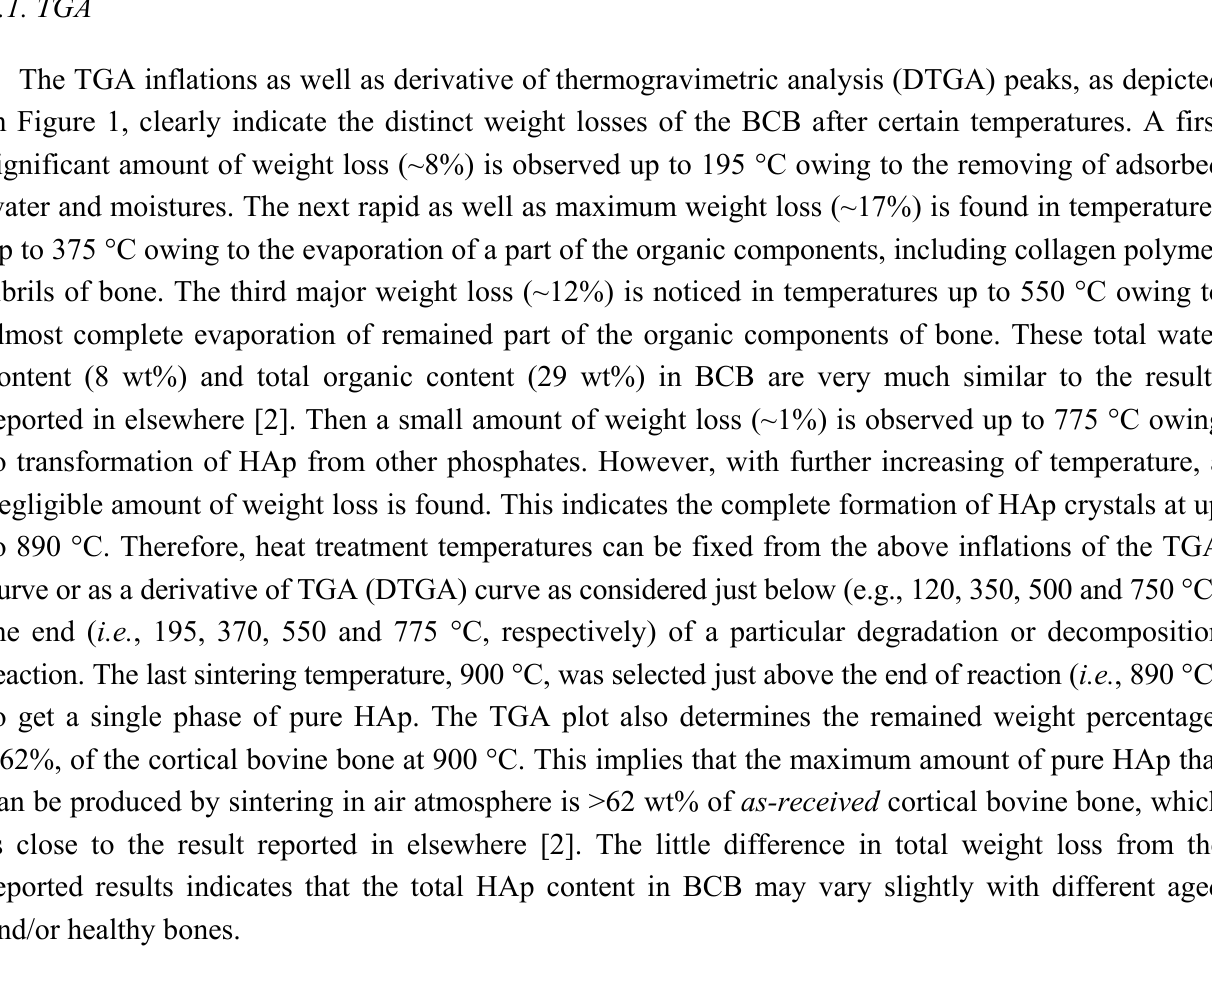
Figure 1. Thermal stability of the samples by thermogravimetric analysis (TGA) and derivative of thermogravimetric analysis (DTGA) in air